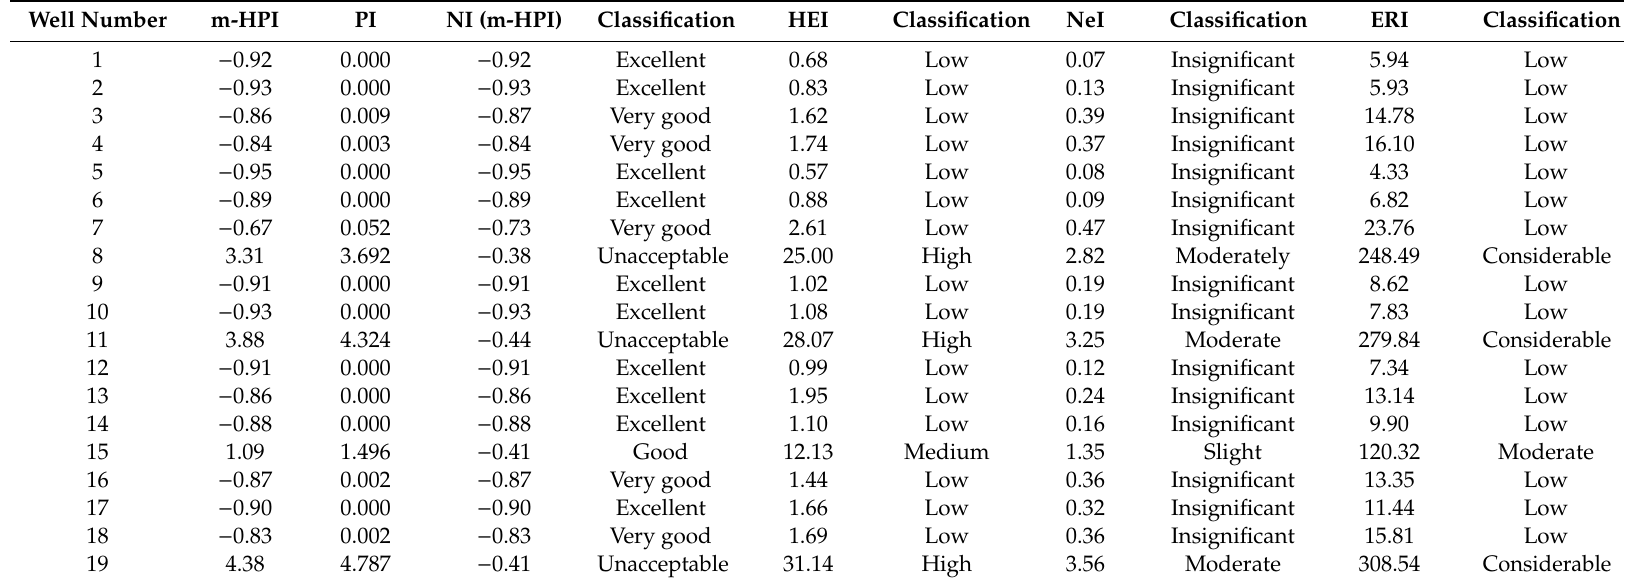
Table 5. Pollution evaluation indices of well water samples in the study